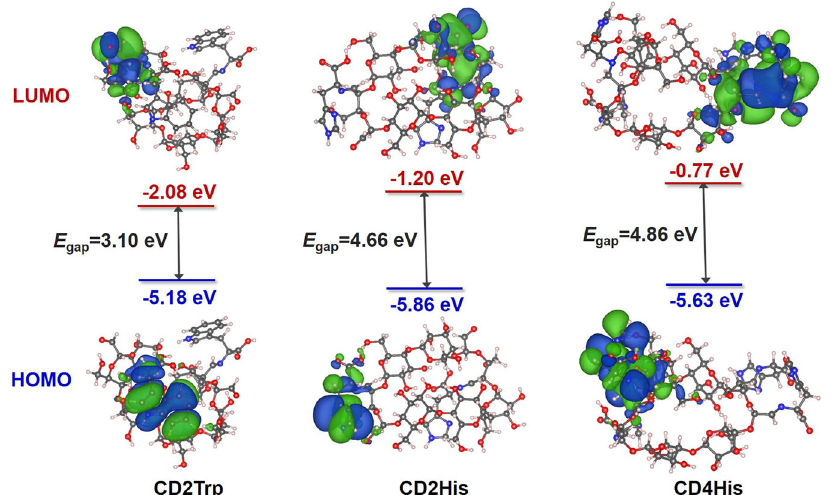
Fig. 5 | Electron density distributions of HOMO and LUMO levels of CD2Trp, CD2His, and CD4His monomers at B3LYP/6-311G(d) level. The 2, 2, and 4 in CD2Trp, CD2His, and CD4His represent the stoichiometric ratios of AAs to CDA.